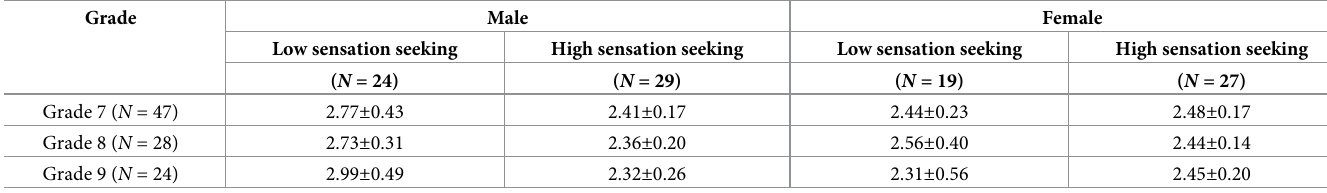
Table 1. Mean and standard deviation of latency of first fixation during road crossing for adolescents(s). Grade Male Female Low sensation seeking High sensation seeking Low sensation seeking High sensation seeking ( N = 24) ( N = 29) ( N = 19) ( N = 27) Grade 7 ( N = 47) 2.77 ± 0.43 2.41 ± 0.17 2.44 ± 0.23 2.48 ± 0.17 Grade 8 ( N = 28) 2.73 ± 0.31